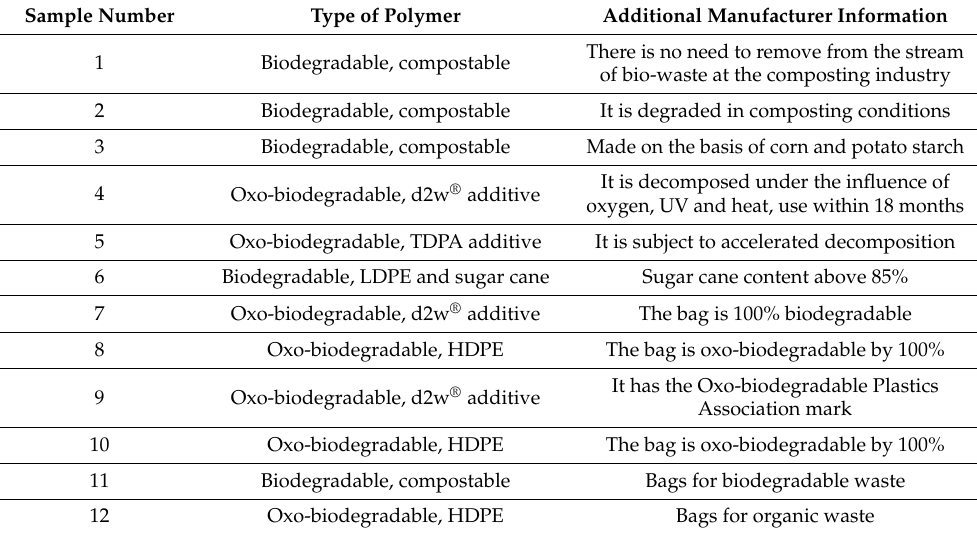
Table 1. The most important information about the samples selected for